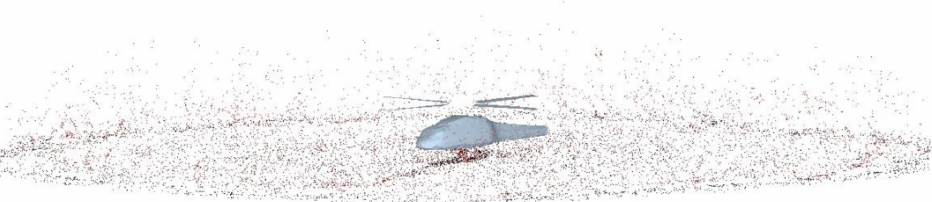
Figure 18. The average height of particles in 4 s and the average velocity of particles in 3 s.